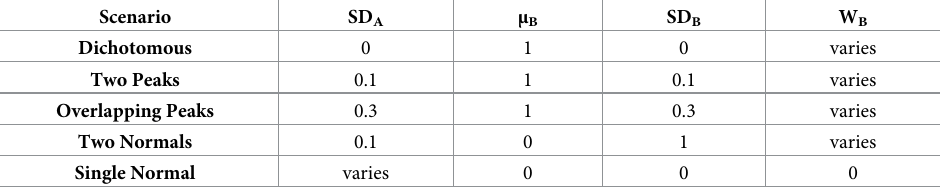
Table 2. Model parameters for different effect size distributions. Columns show parameters used for each version of the model. The weight of the second normal W B is varied to determine prevalence for the different simulations. When a single normal is used, this is accomplished by varying SD A . For Figs 2–4, W B was set to 0.1, 0.3, 0.5, 0.7 and 0.9 to achieve prevalences between 0.1 and 0.9 in the first 4 models. In the Single Normal model, SD A was set to 0.3, 0.5, 0.8, 1.5 and 4 to approximate the same